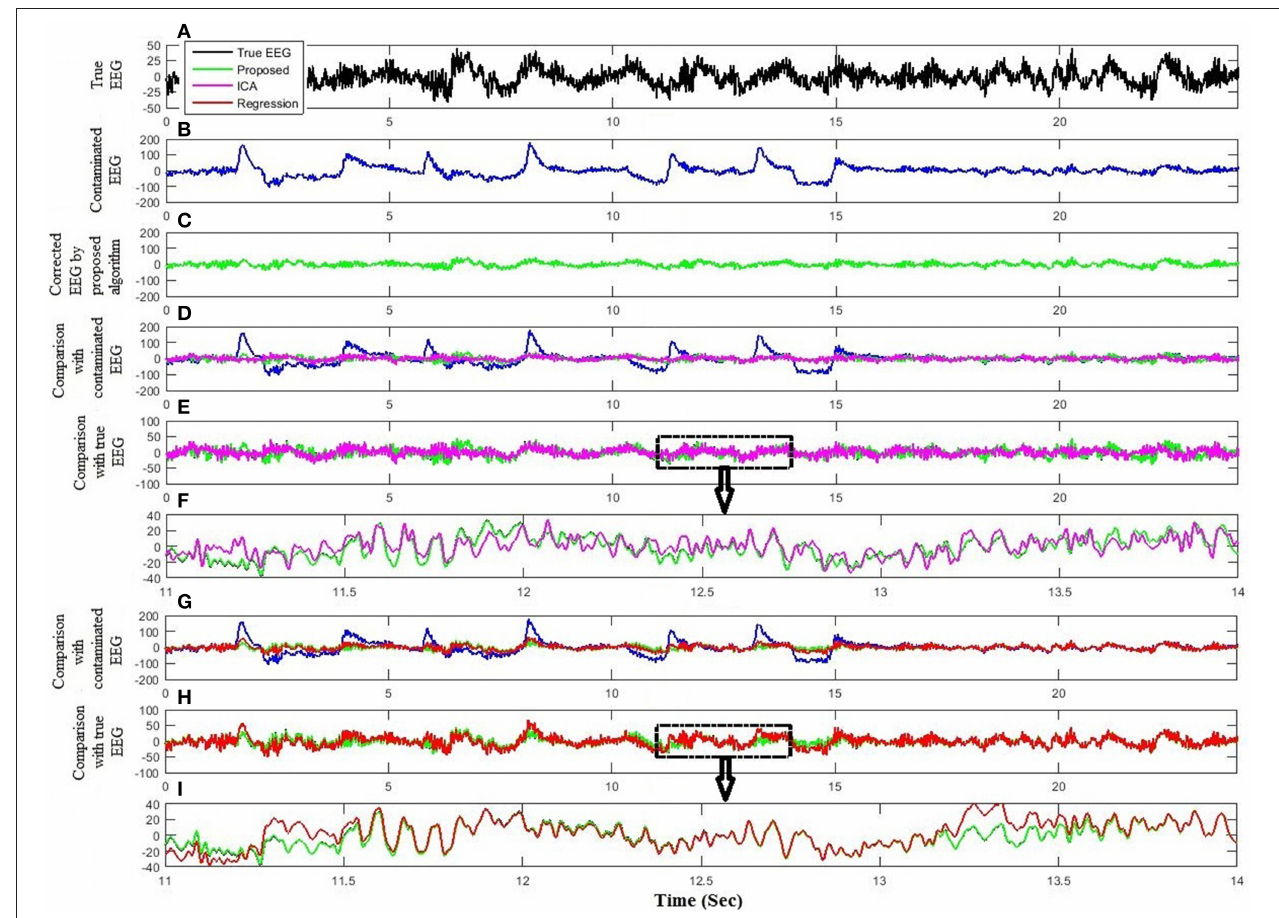
FIGURE 4 | Comparison of the proposed method with ICA and regression analysis using simulated dataset. (A) Simulated true EEG data. (B) Artificially contaminated EEG data. (C) Reconstructed EEG by the proposed method. (D) Comparison of the proposed method and ICA reconstructed EEG with artificially contaminated EEG. (E) Comparison of the proposed method and ICA reconstructed EEG with simulated true EEG. (F) Partial enlargement of highlighted region. (G) Comparison of the proposed method and regression method reconstructed EEG with artificially contaminated EEG. (H) Comparison of the proposed method and regression method reconstructed EEG with simulated true EEG. (I) Partial enlargement of highlighted